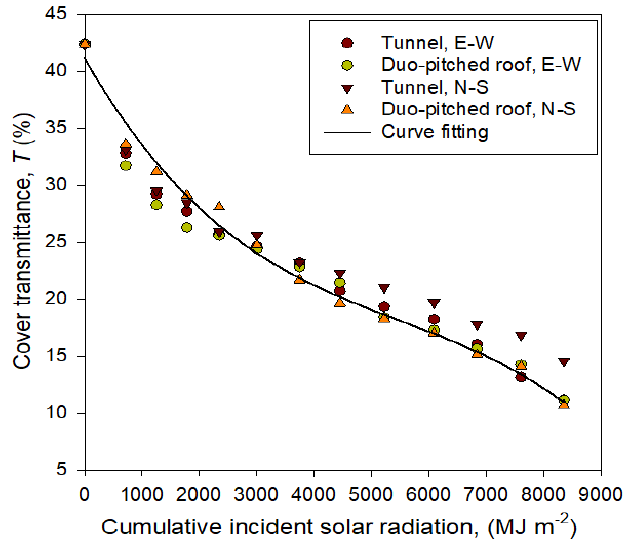
Figure 11. Degradation of the cover transmittance ( T% ), for the four prototypes tested, affected by the cumulative incident solar radiation flux (MJ m − 2 ) during the exposure time, from 1 October 2019,